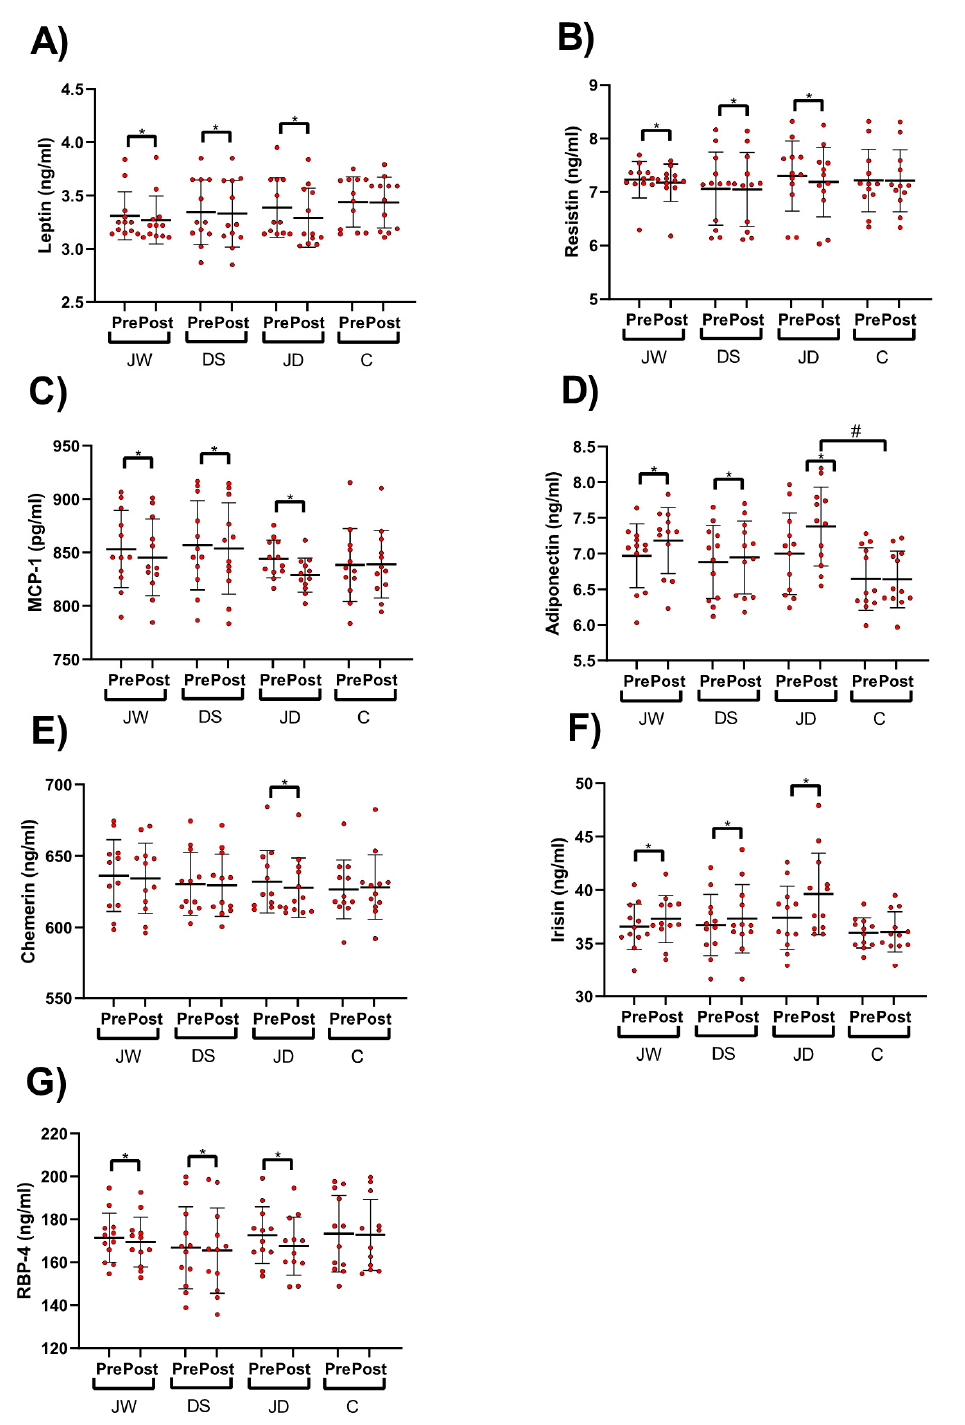
Figure 3. Pro-Inflammatory and anti-inflammatory adipokines concentrations. ( A ) Leptin, ( B ) ( C ) Monocyte chemoattractant protein-1 (MCP-1), ( D ) Adiponectin, ( E ) Chemerin, ( F ) Irisin, ( G ) Resistin. ( C ) Monocyte chemoattractant protein - 1 (MCP-1), ( D ) Adiponectin, ( E ) Chemerin, ( F ) Irisin, Retinol-binding protein-4 (RBP-4). * p < 0.05 di ff erent from pre-training; # between group di ff ( G ) Retinol-binding protein-4 (RBP-4). * p < 0.05 different from pre-training; # between group difference.